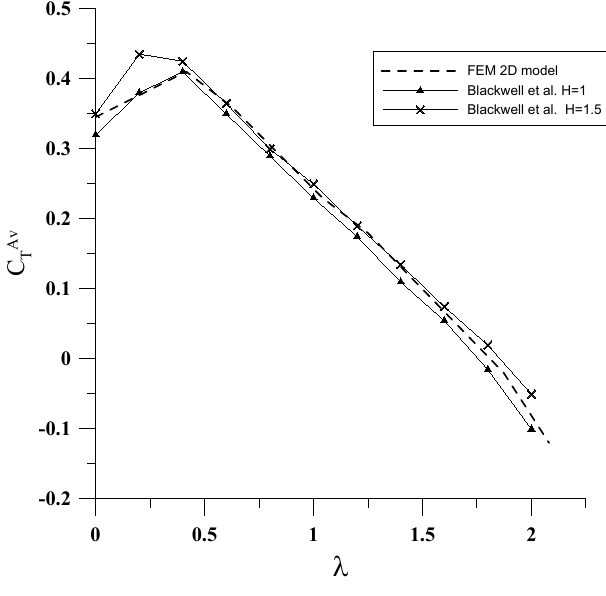
Figure 6. Averaged C Av coefficients for CFD model vs. experimental data T